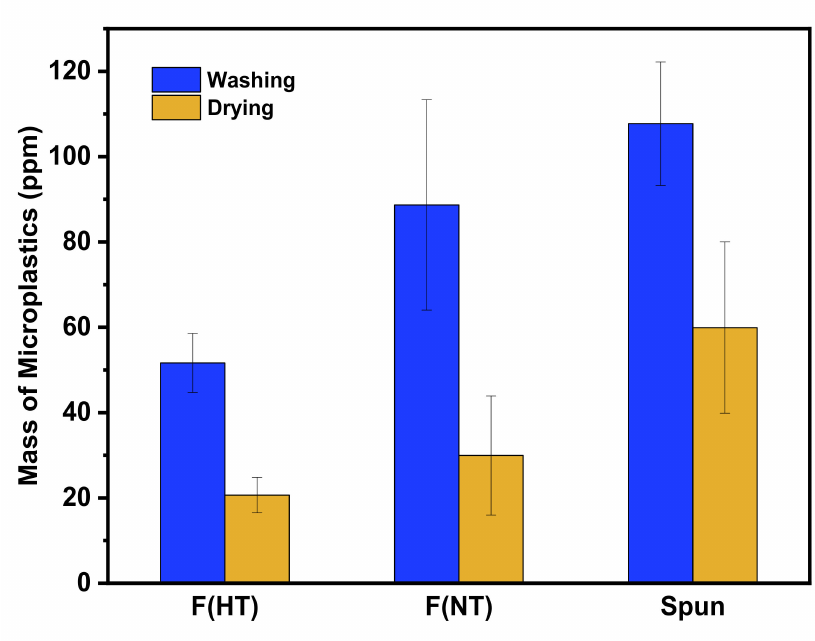
Figure 5. Comparison of microplastics during washing and